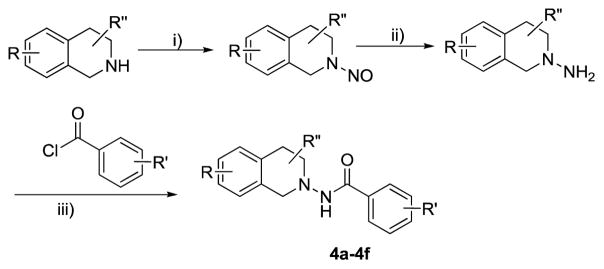
Reaction Conditions: i) NaNO2, H2O, 0 °C, ii) Zn, CH3COOH, iii) Acyl Chlorides, Et3N, THF; R = 7-CN, 6,7-di-OCH3, 6-CI, 6-OCO-C6H4-C2H5; R′ = 4-C2H5-C6H4, R″ = 1-CH(CH3)2, 1-COOCH3